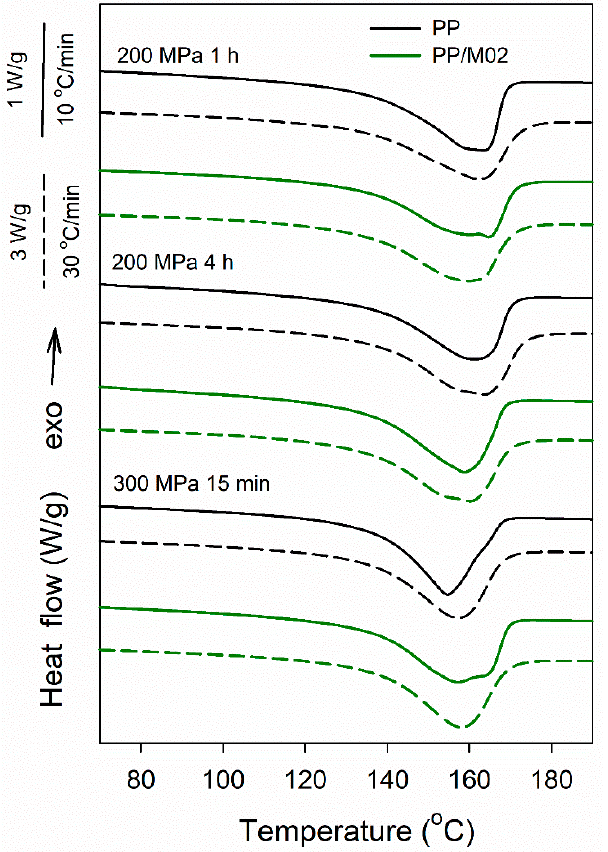
Figure 10. DSC heating thermograms recorded at rates of 10 °C/min (solid lines) and 30 °C/min (dashed lines) for neat PP and PP/M02 crystallized according to protocol II.